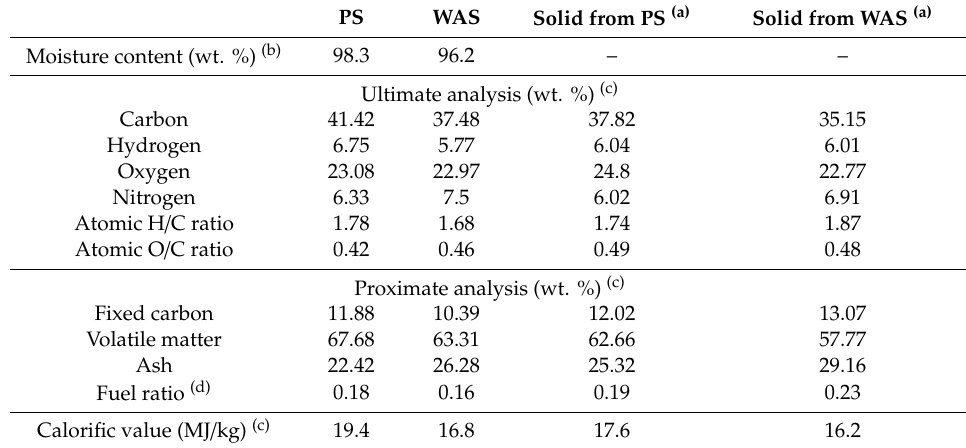
Table 3. Characteristics of the solid byproduct after the lipid